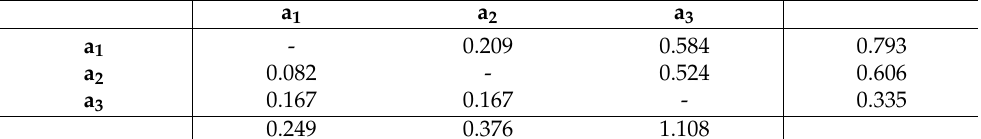
Table 7. Matrix of the determined outranking relations as well as input and output flows.